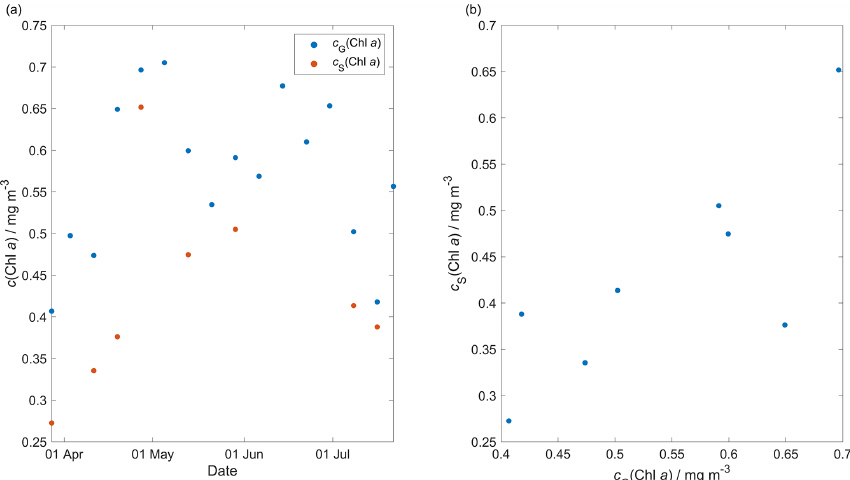
for a vertical eddy diffusivity ( K z ) of 10 − 5 m 2 s − 1 (Naveira Garabato et al., 2004). The effect of F v (O 2